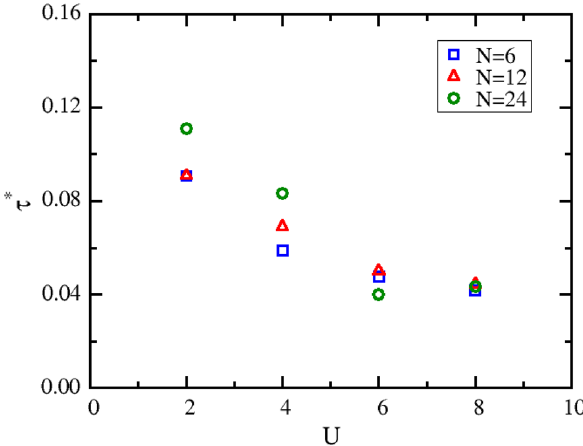
Figure 3. The convergence criterion ( τ ∗ ) varying with the on-site Coulomb interaction strength ( U ). Square, triangle and circle symbols represent the systems with lattice size of N = 6, 12 and 24, respectively.